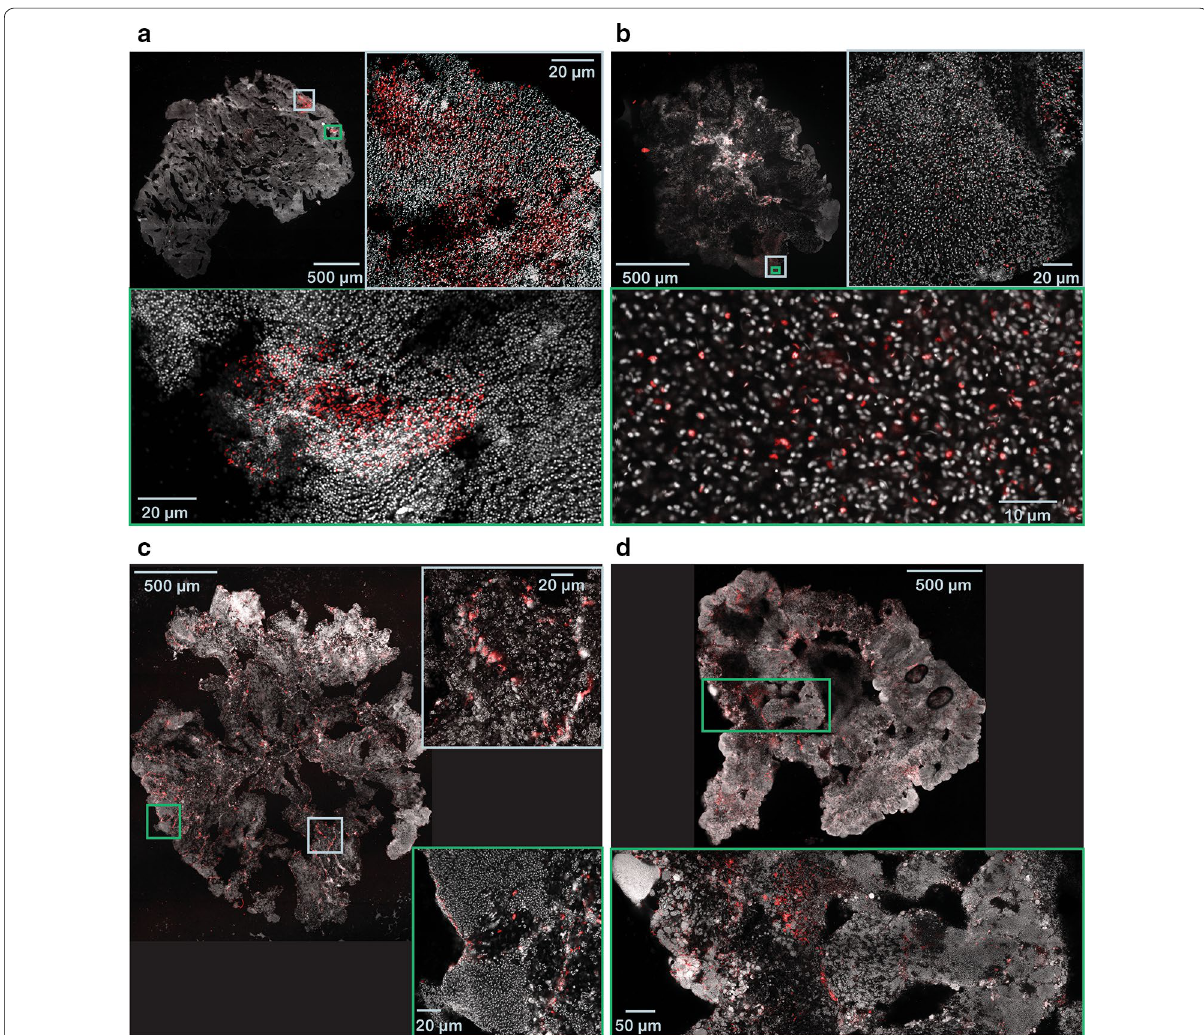
Fig. 5 FISH‑CLSM images of selected bacteria with retention ratios significantly higher than one. Cryosections of granules at and detailed sections at 400 magnification. a , b Genus Bdellovibrio in granules from R1; c , d Flavobacterium spp. in granules from R1. Grey total × cells (Syto 40); red genus Bdellovibrio ( a , b ) and Flavobacterium spp. ( c , d